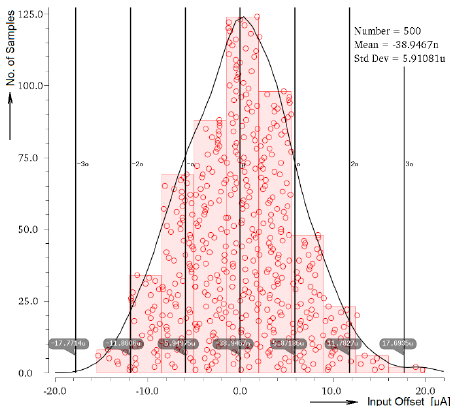
Figure 14. Monte Carlo input offset matching simulation.